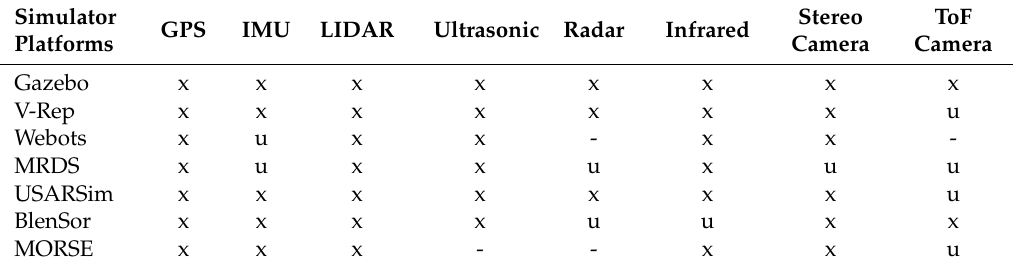
* Table Legend: x - Yes | u – Unknown or couldn’t be determined | - –